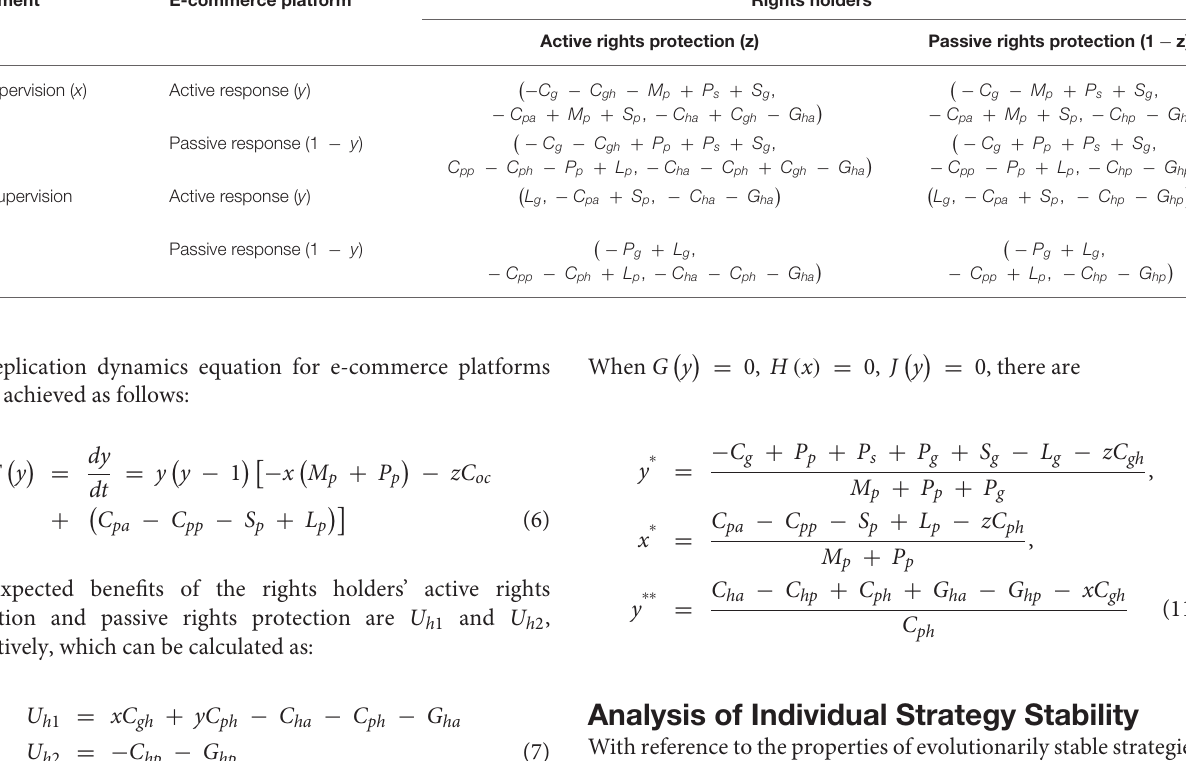
TABLE 2 | Payoff matrix among the government, e-commerce platforms, and rights holders.